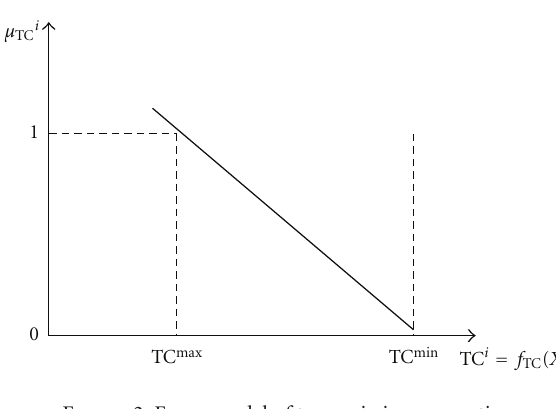
Figure 2: Fuzzy model of transmission congestion.